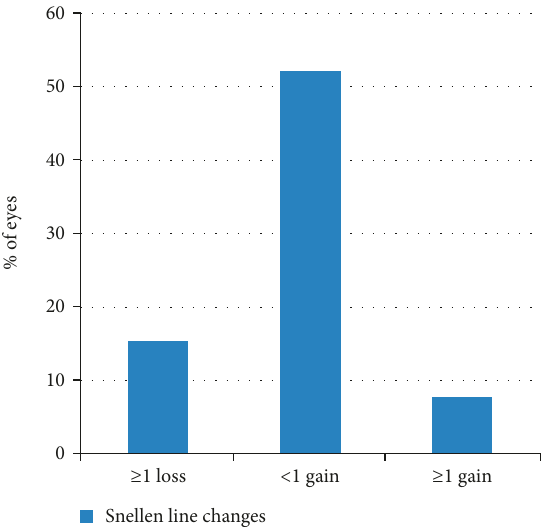
Figure 1: Visual gain/loss of the study patients